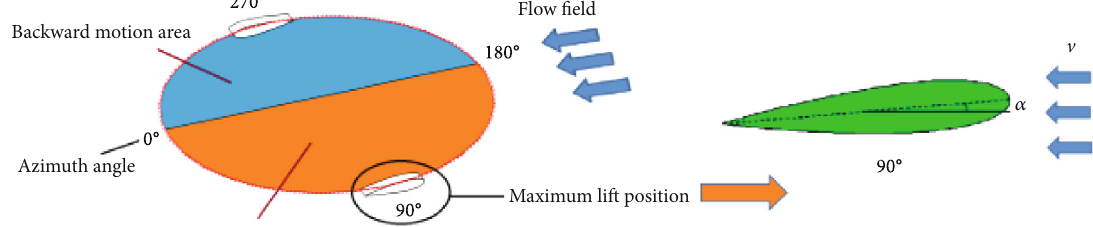
Figure 14: Moving trajectory of blades and setting angle α